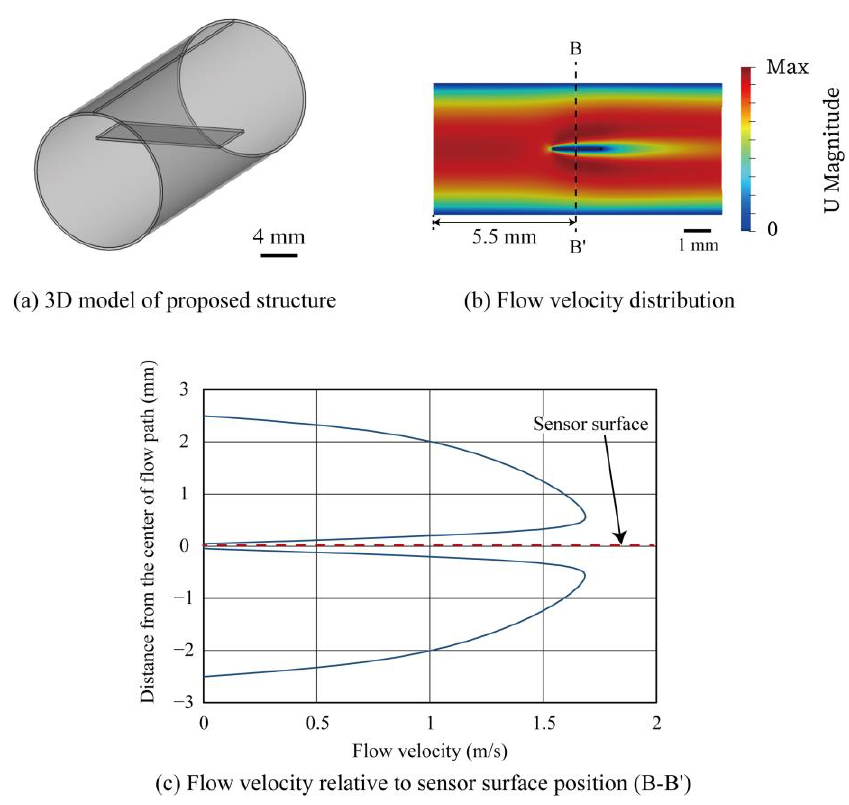
Figure 3. Fluid analysis with the proposed structure. The sensing structure was installed on a plate in the center of the circular tube (at 0 mm position).